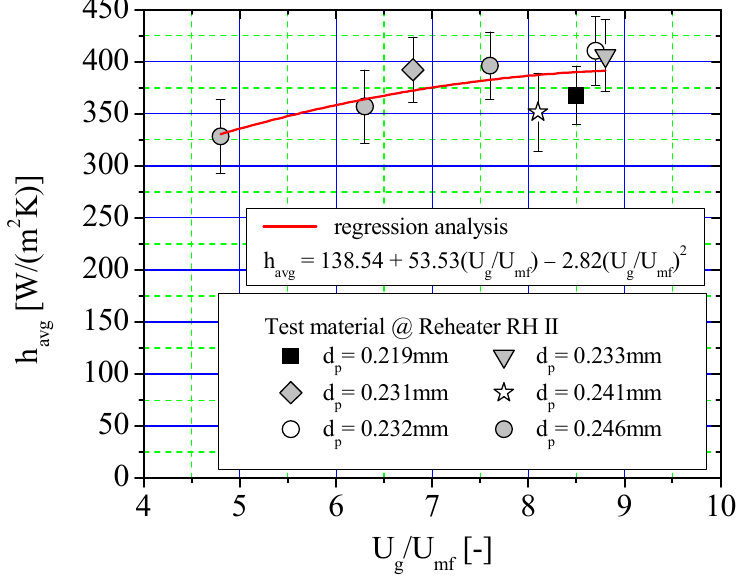
Figure 9. Impact of fluidization number on average heat transfer coefficient.